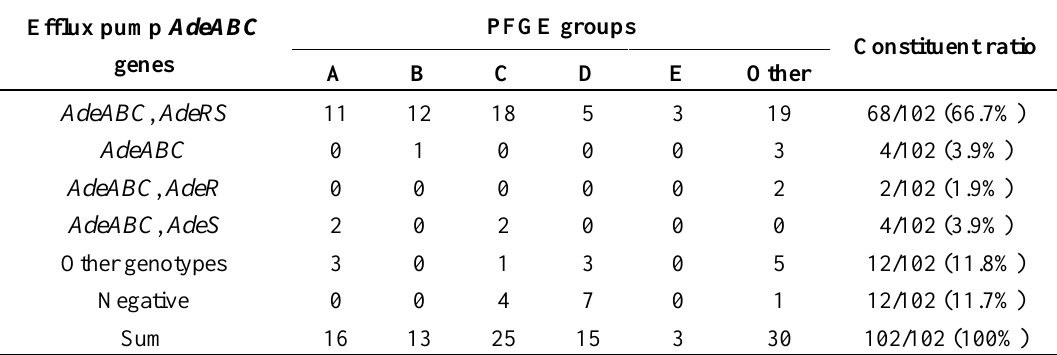
Table 4. Distribution of AdeABC efflux pump genes in different groups of clinical drug-resistant A. baumannii